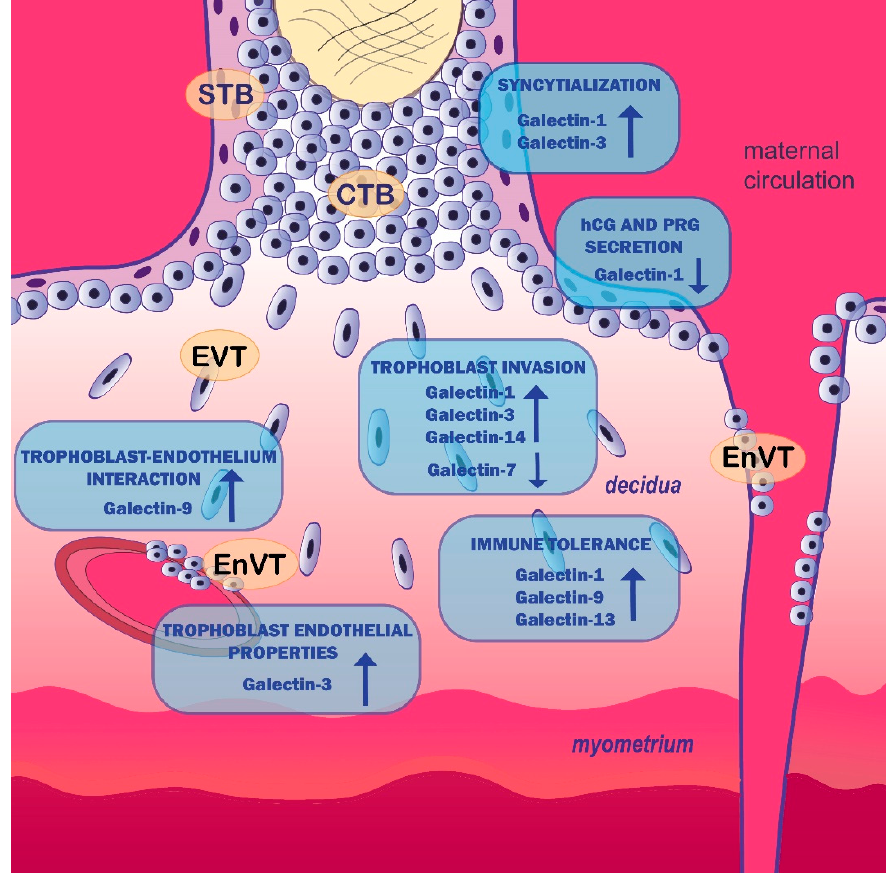
Figure 1. The proposed functions of galectins in the placentation process. STB—syncytiotrophoblast; CTB—cytotrophoblast; EVT—extravillous trophoblast; EnVT—endovascular trophoblast; PRG—progesterone; hCG—human chorionic gonadotropin. (Illustrated by Milica Jovanovi ć Krivoku ć a)